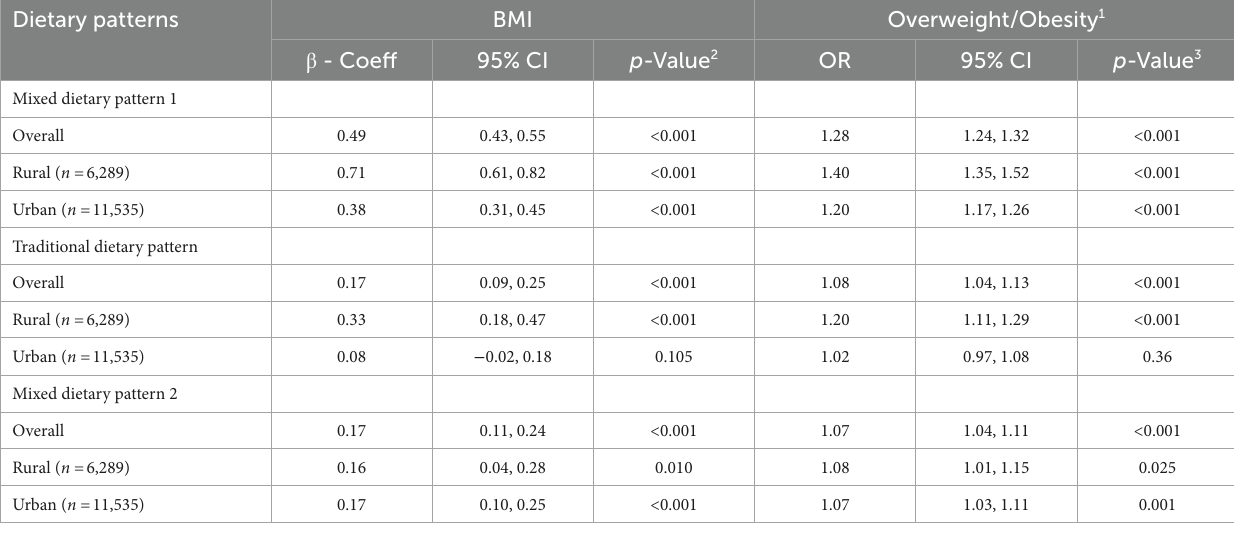
TABLE 4 Associations between household principal component dietary patterns and adult BMI (continuous and binary) overall and by area of residence ( n = 17,824 adults). Dietary